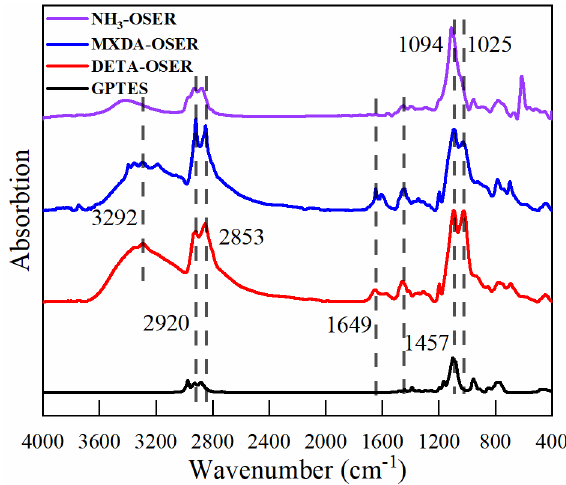
Figure 2. FTIR spectra of NH 3 -OSER, MXDA-OSER, DETA-OSER and GPTES.